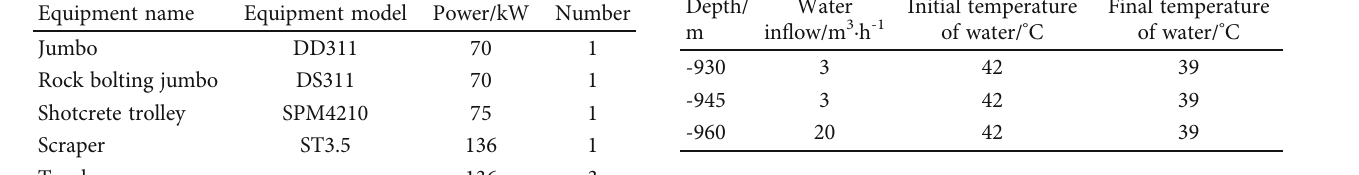
Table 3: Groundwater parameters.